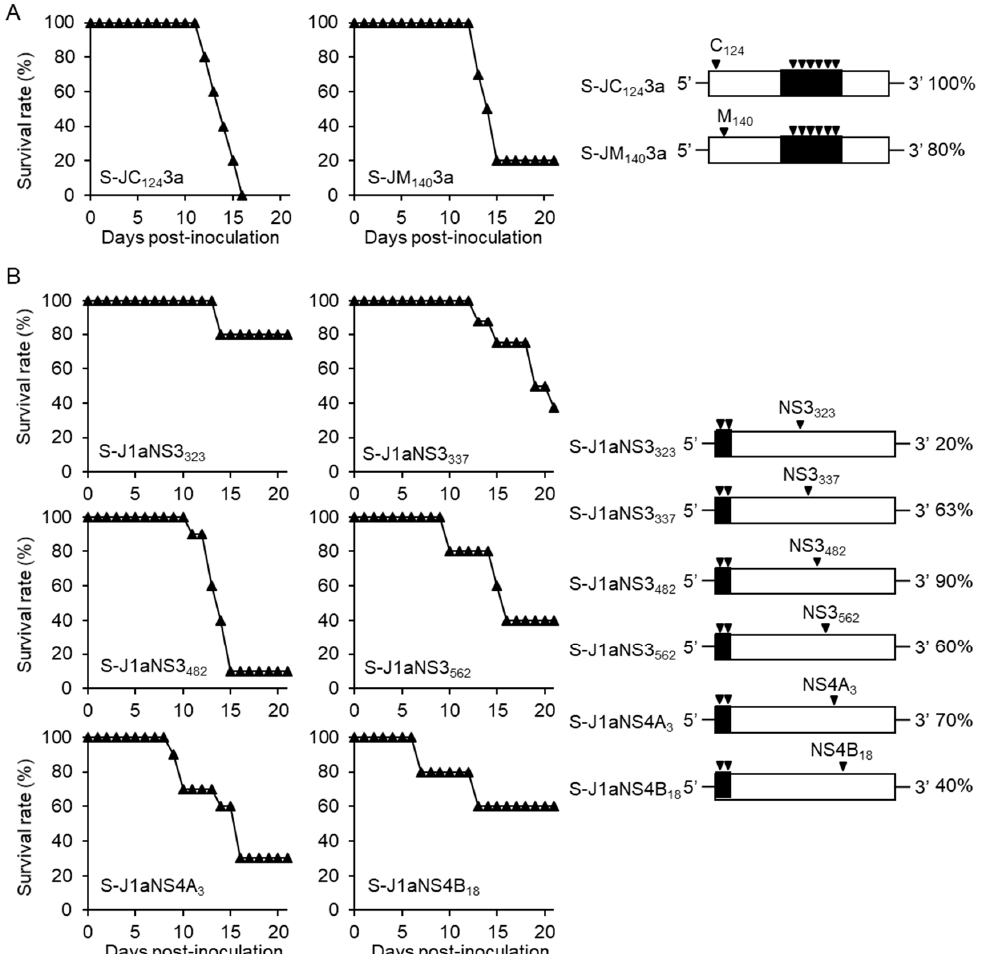
Figure 3. Mortalities of mice infected with S-J13-based recombinant viruses. ( A ) Survival curves and mortality rates of mice infected with 10 4 pfu of S-J13a ( n = 10) and S-J13b ( n = 5) based on S-J13, in which regions 3a (NS3 36 -NS4B 110 ) and 3b (NS4B 111 -NS5 567 ) were replaced with those of JaTH-IC. ( B ) Survival curves and mortality rates of mice infected with 10 4 pfu of S-J1a3 ( n = 10), S-J1b3 ( n = 10), and